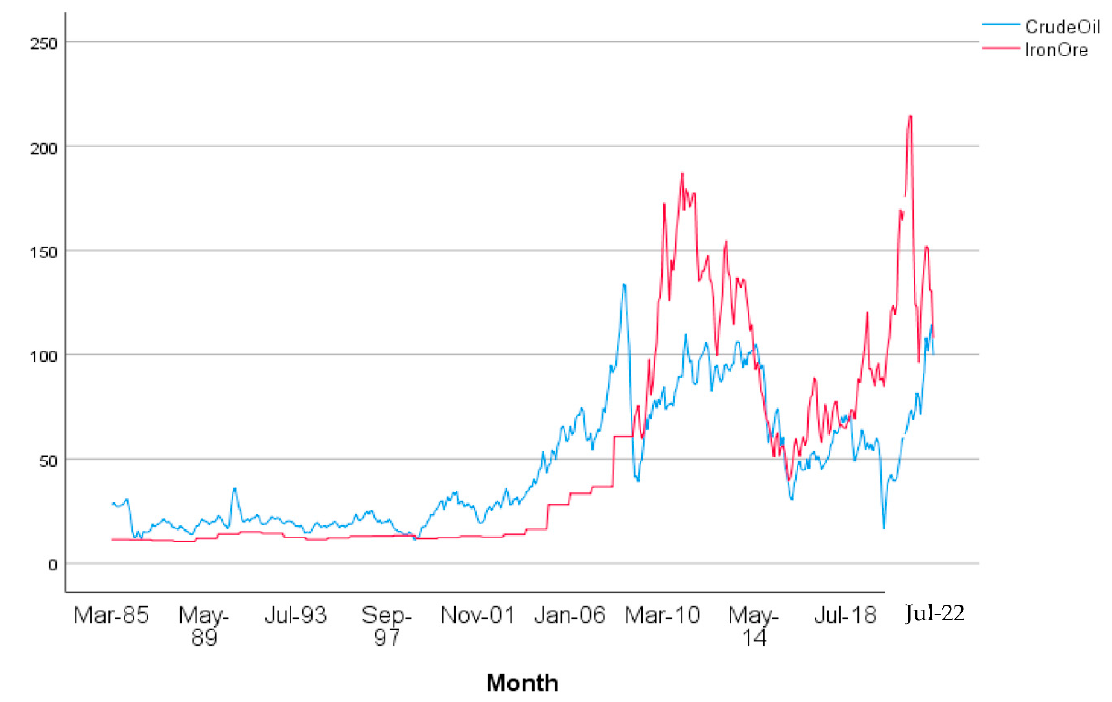
Figure 3. Time-Series Plot of Crude Oil and Iron Ore Price Patterns.